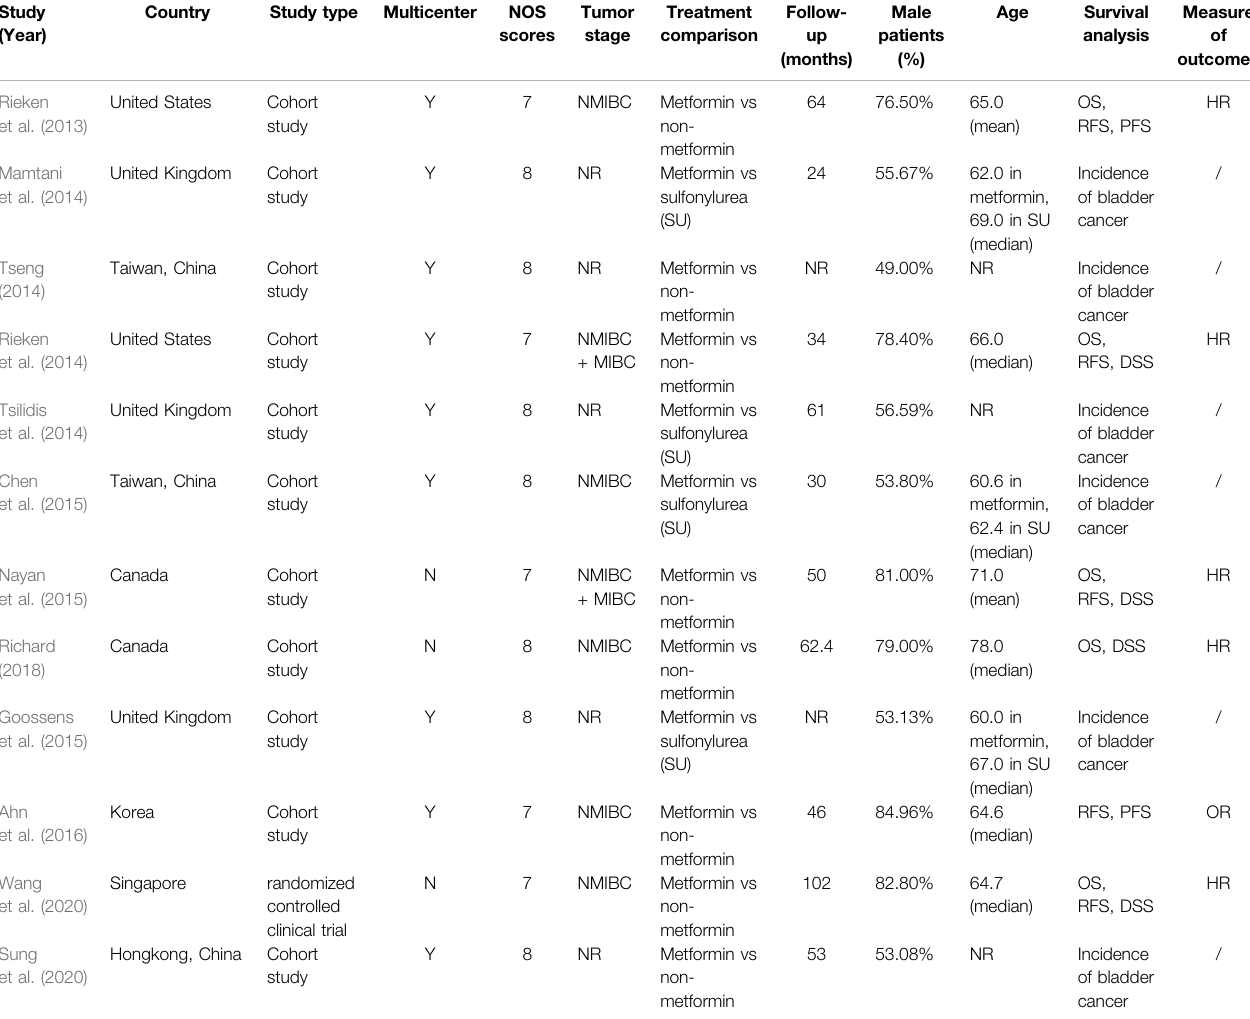
TABLE 1 | Basic characteristics of studies